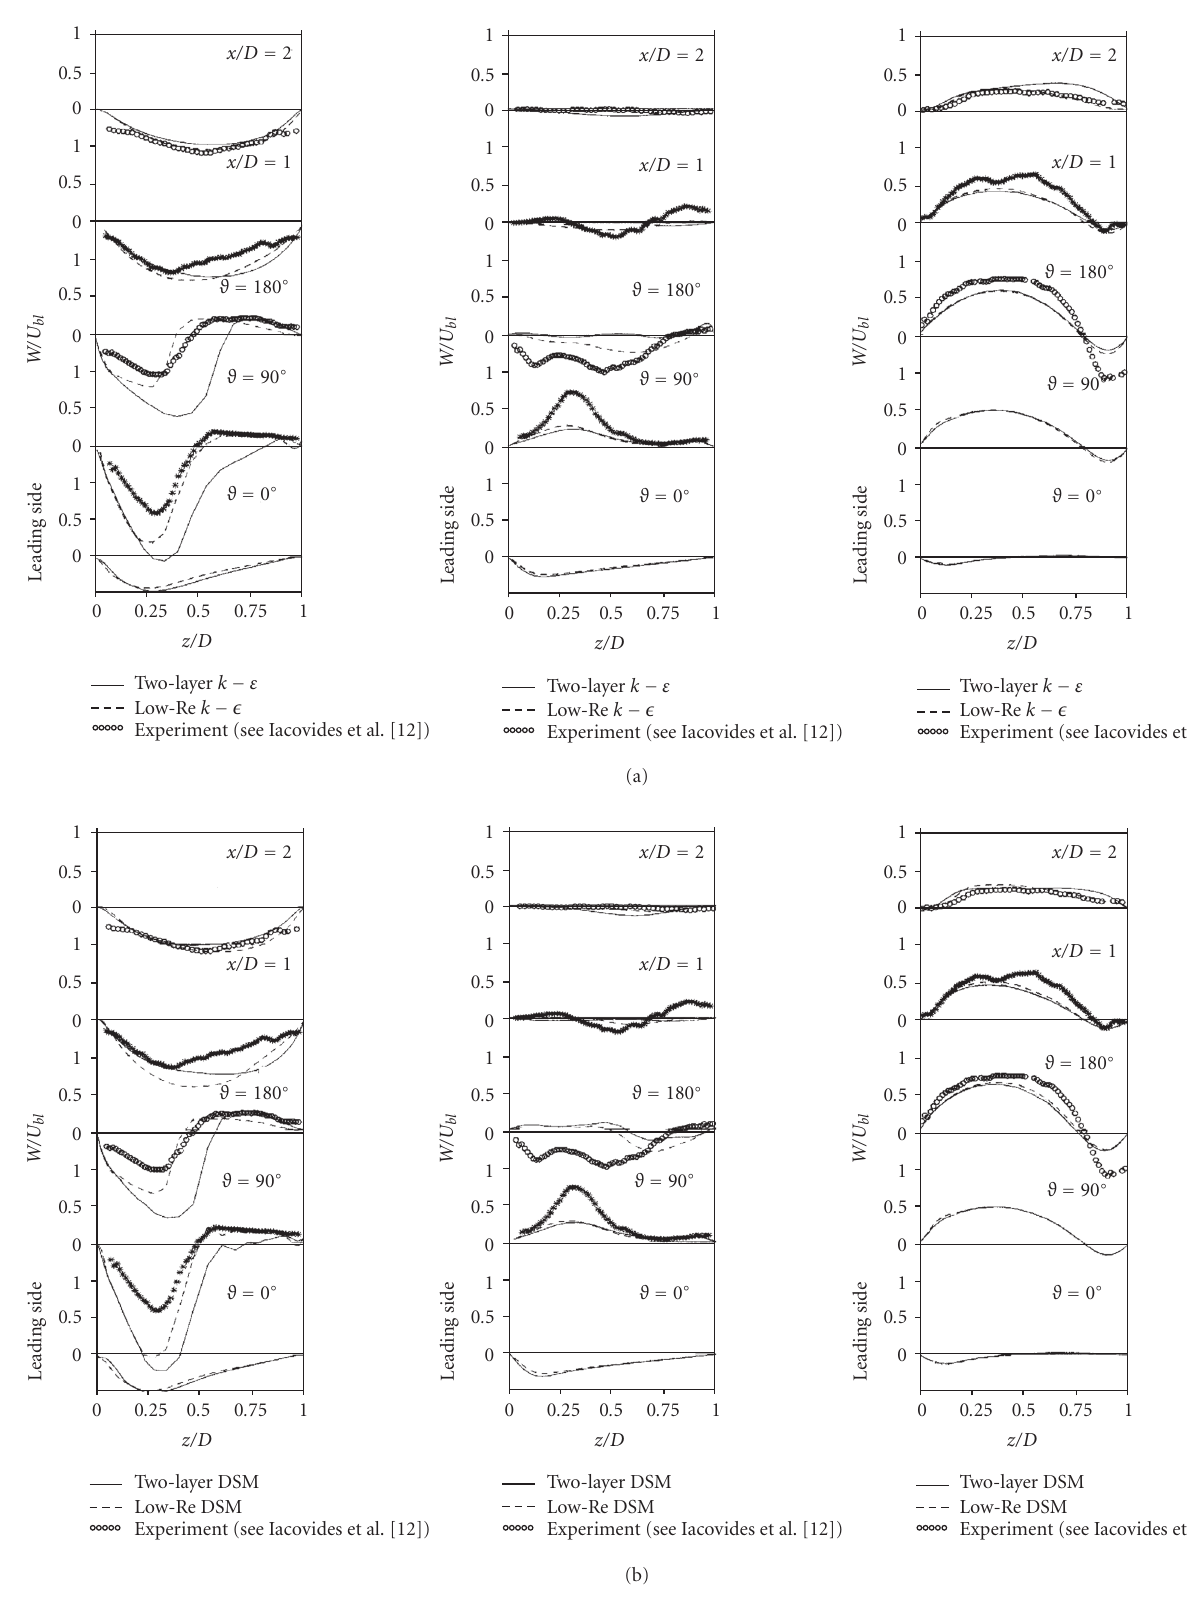
Figure 6: Comparisons between (a) predicted and (b) measured profiles of mean cross-duct velocity. The left plot indicates inner plane C, the middle plot indicates mid-plane B, and the right plot indicates outer plane